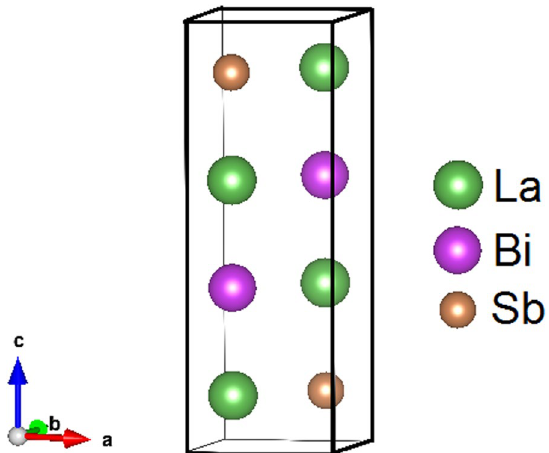
Figure 7. 1 × 1 × 2 supercell of LaSb/LaBi consisting of alternate unit cells of LaSb and LaBi.